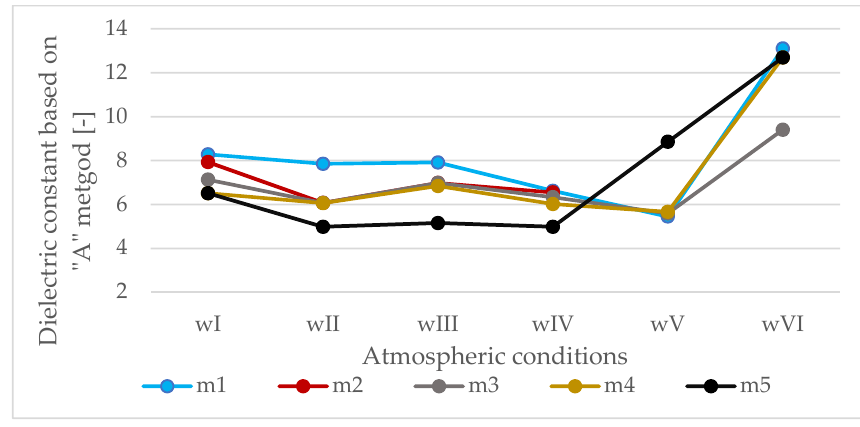
Figure 7. Dielectric constants calculated based on the amplitudes (“A” method).